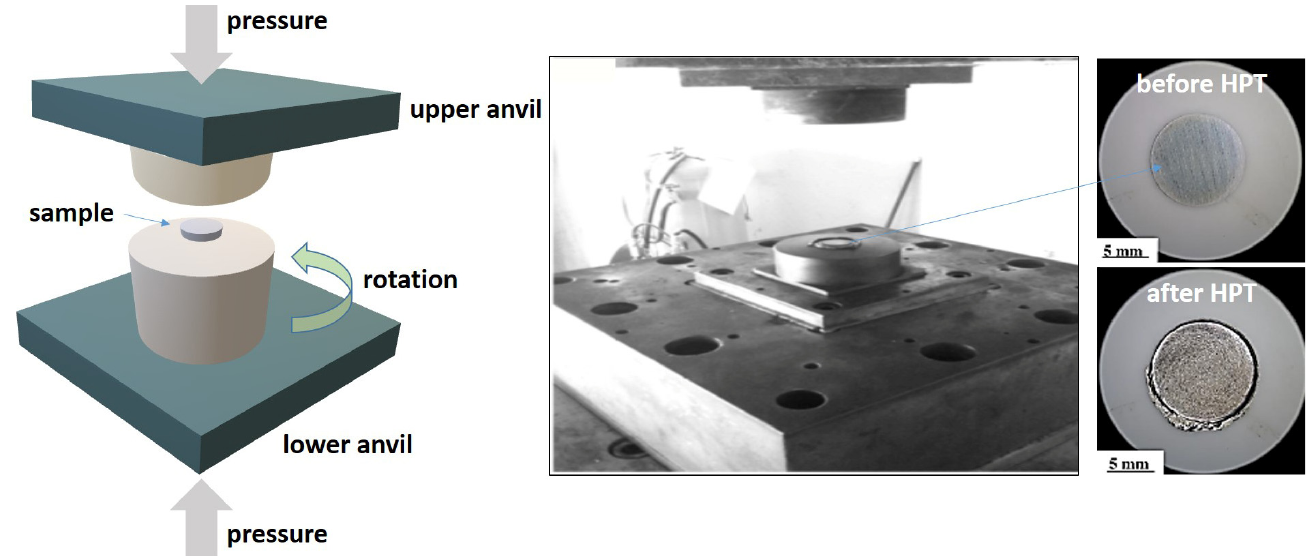
Figure 1. Schematic drawing of HPT process and CCM samples before and after HPT.